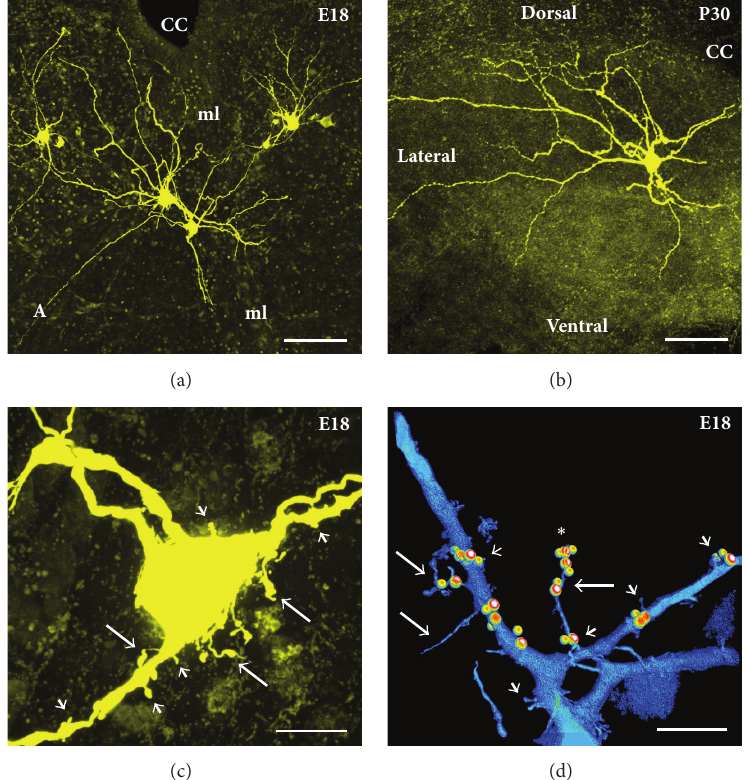
Figure 3: Morphological properties of hypoglossal motoneurons in brainstem slices obtained from embryonic and adult C57/Bl6 wild-type mice (for methodology see Kanjhan and Bellingham, 2013 [26, 27]). (a) Image showing 4 hypoglossal motoneurons filled with Neurobiotin in a 300 𝜇 m slice preparation obtained from a mice at embryonic day 18 (E18). Note that the motoneuron on the dorsal right-hand side is dye-coupled to 4 adjacent motoneurons. Two motoneurons on the ventromedial portion of the hypoglossal nucleus have dendrites crossing the midline (ml) to the contralateral side. Axon (A) of one of the motoneurons is clearly visible projecting in the ventrolateral direction to join the hypoglossal nerve outlet. (b) A hypoglossal motoneuron from an adult mouse at postnatal day 30 (P30). Note a significantly larger dendritic tree in the adult mice. (c) A high-power confocal image showing filopodia (long arrows) and spine-like processes (short arrows) at the soma and primary dendrites of a motoneuron from a WT mouse at E18. (d) A rendered 3D reconstruction generated by Imaris software illustrating an overlapping localization of the presynaptic vesicular glutamate transporter-2 (VGLUT-2) terminals (small spheres) and the postsynaptic density protein-95 (PSD-95) (larger spheres) on filopodia (note as many as 4 excitatory synaptic contacts on a single filopodium marked as ∗ ) and spine-like processes on the primary dendrites of a motoneuron from an E18 WT mouse. CC: central canal. Scale bars = 100 𝜇 m in (a and b); 10 𝜇 m in (c and